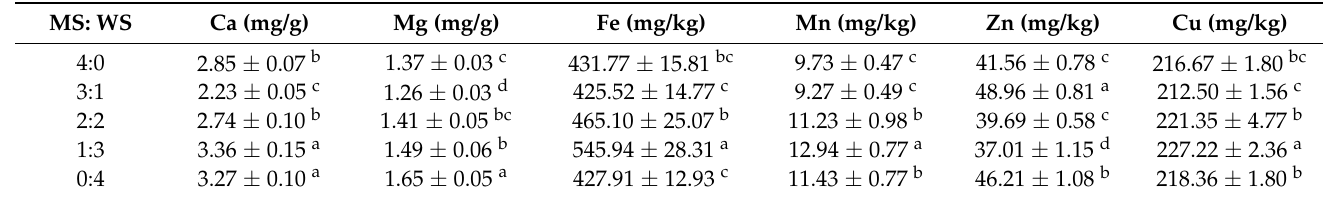
Table 3. Mineral nutrition of basidiocarp of A. auricula cultivated with different walnut supplemen- tal